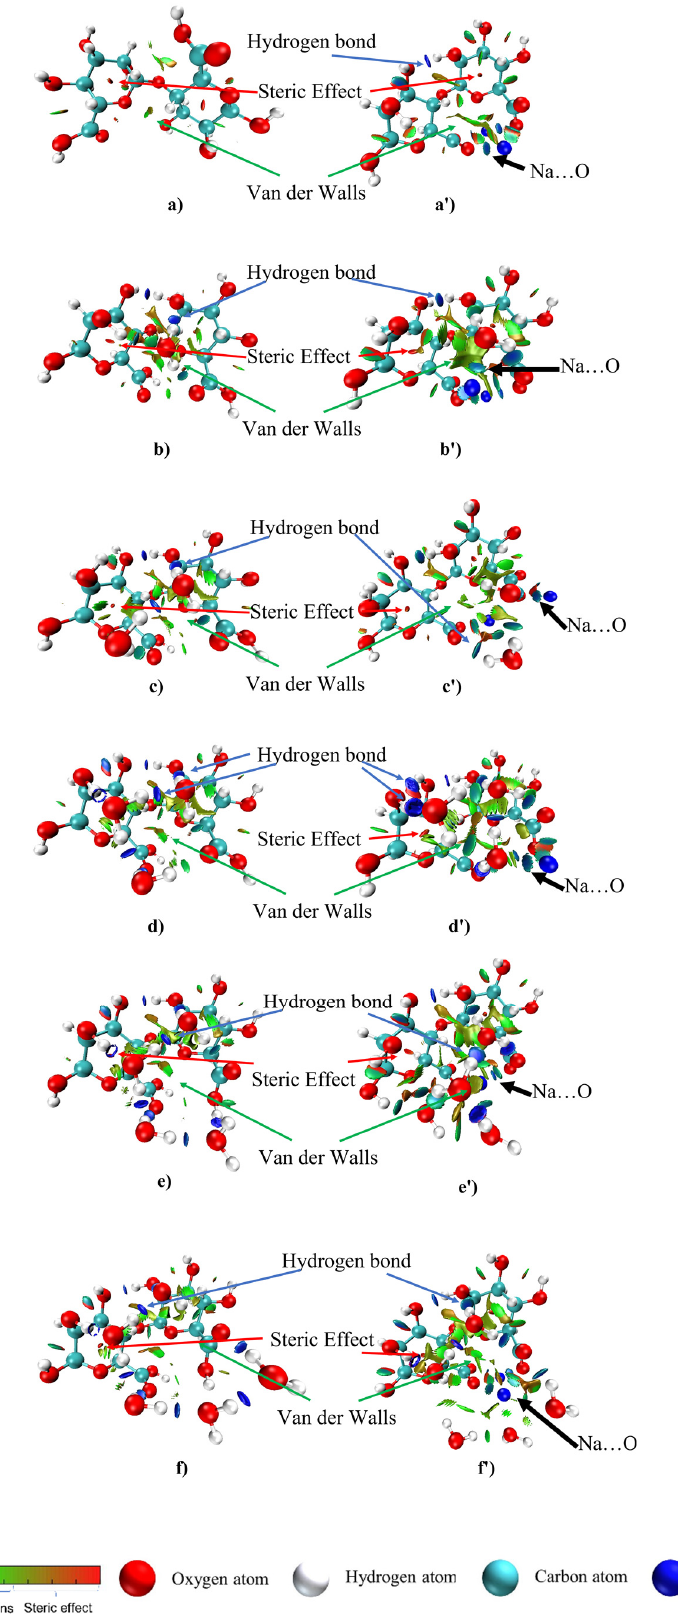
Figure 3. Three-dimensional RDG isosurface of ( a ) Alg, ( a (cid:48) ) SA, ( a – f ) Alg-(H 2 O) complexes, and ( a (cid:48) – f (cid:48) ) SA-(H 2 O) n